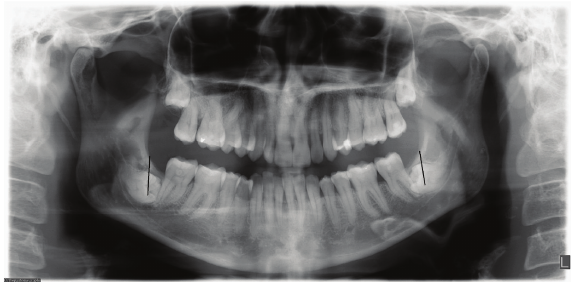
Figure 1: Preoperative panoramic radiograph. The direction of the initial cuts is marked.